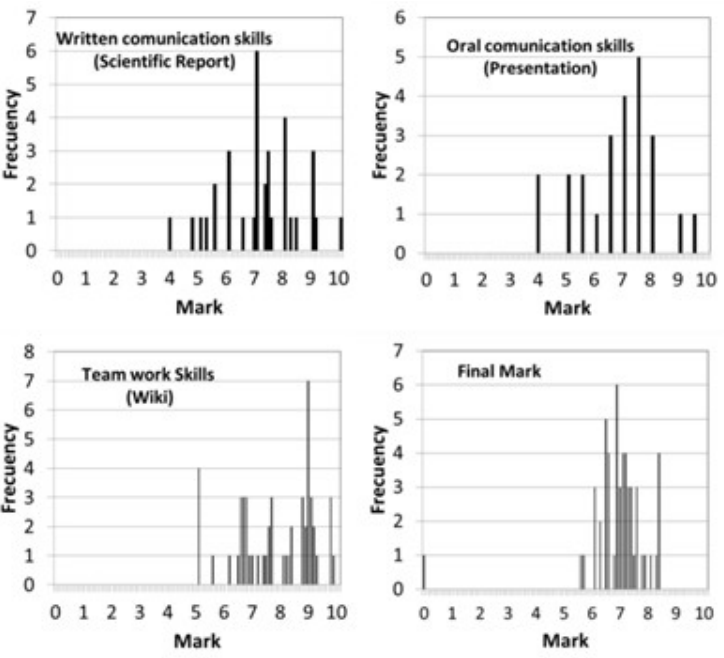
Figure 4. Frequency distributon of academic marks